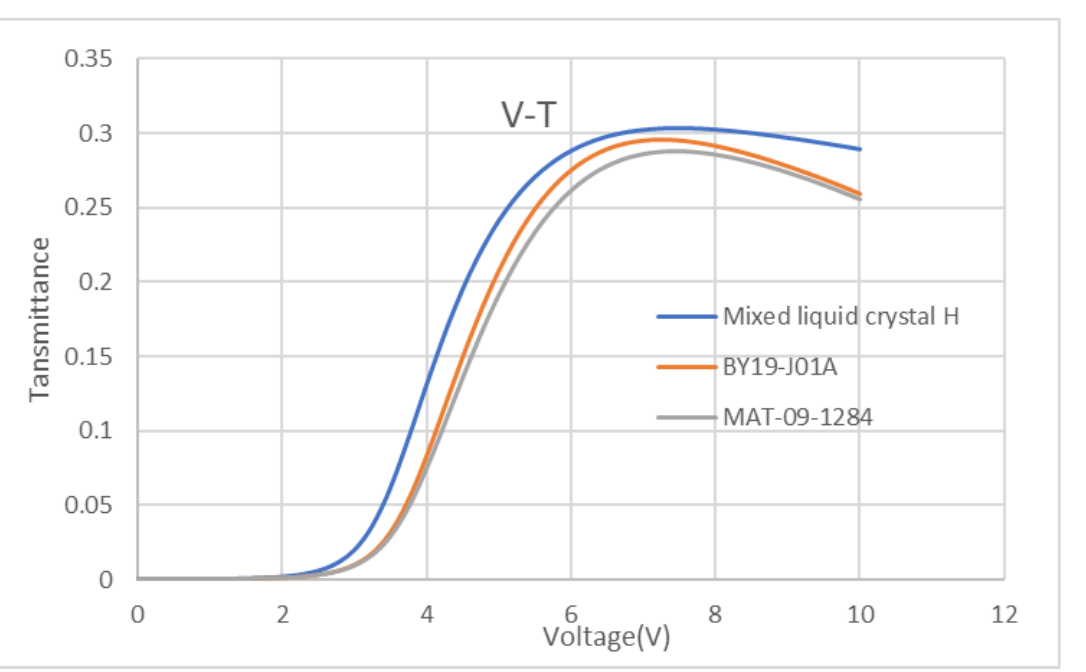
Figure 5. The VT comparison of mixed liquid crystal H with BY19-j01A and MAT-09-1284.